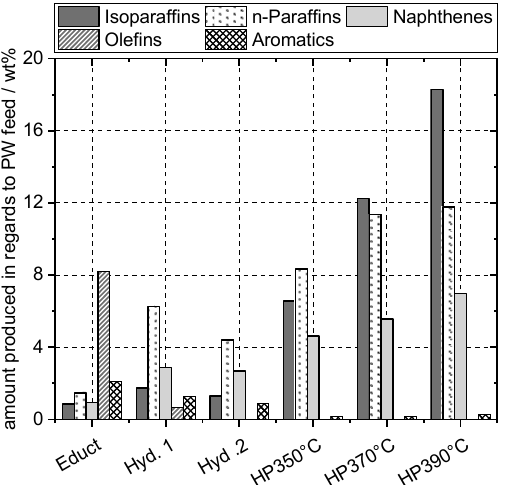
Figure 15. Produced substance groups in the naphtha phase in relation to PW feed.